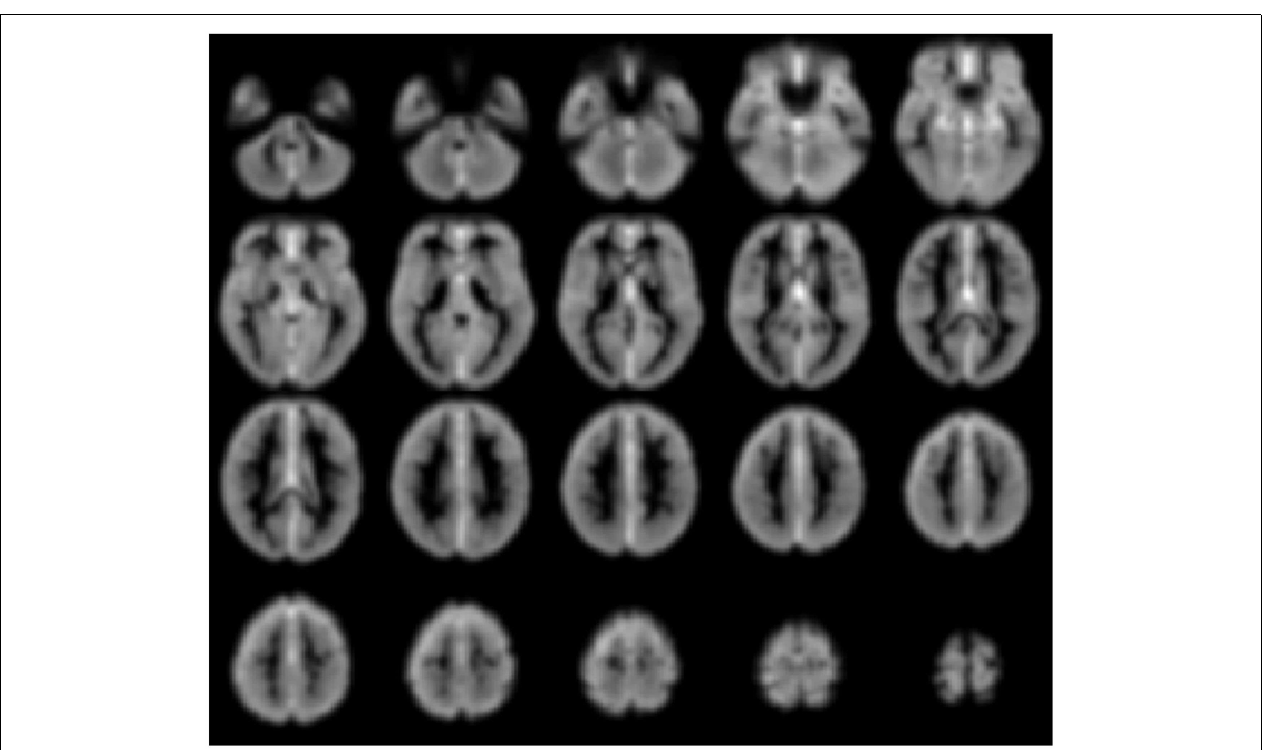
FIGURE 3 | Gray-scale short axis MR images (from n = 42 healthy control subjects) with contrast reflecting the functional connectivity of each voxel as measured by the network measure of degree (brighter colors